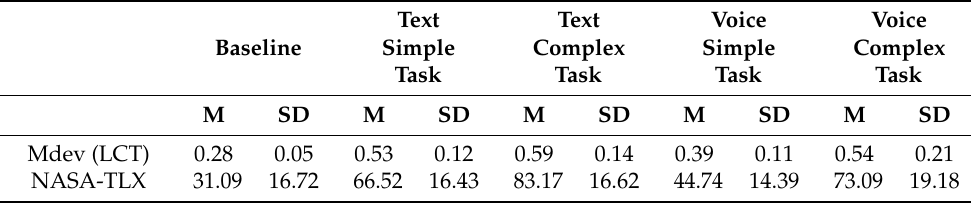
Table 1. Means and standard deviations of the mean deviation in the LCT and NASA-TLX scores in the baseline and dual-task